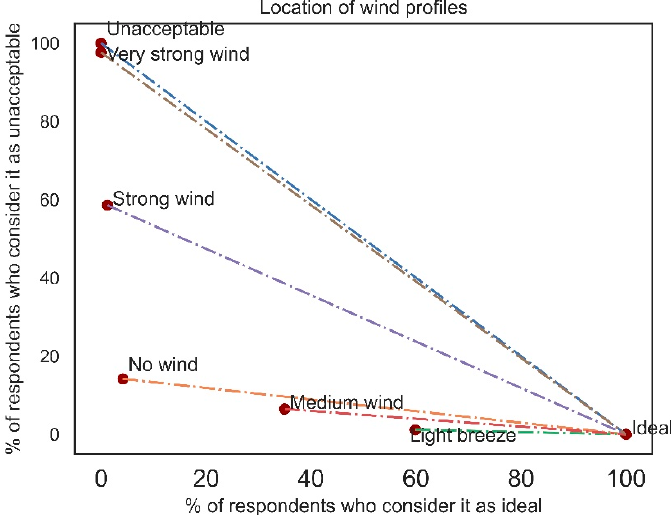
Figure 10. Percentage of respondents considering a specific wind profile as ideal and unacceptable, and relevant ‘distance’ between these and the ‘theoretically ideal’.